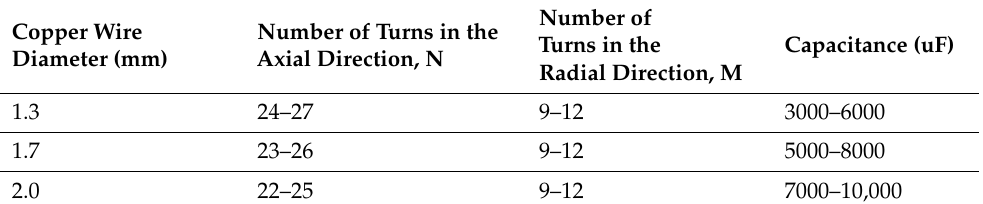
Table 1. The ranges of design variables for single-stage coil guns by copper wire